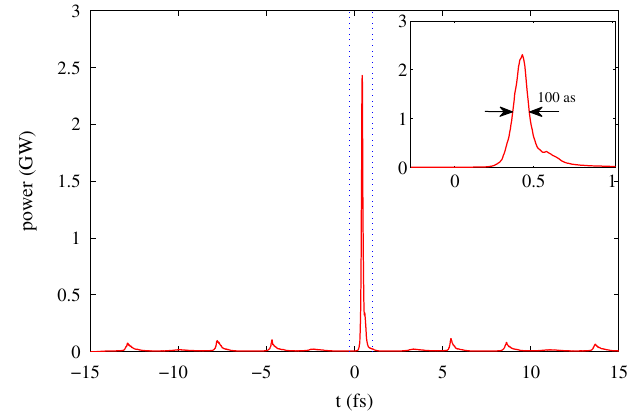
FIG. 7. (Color) A typical x-ray power profile at an undulator length of 50 m with an optimized undulator tapering of 1% over 55 m starting from 15 m. The inset zooms in the central spike in the dotted blue